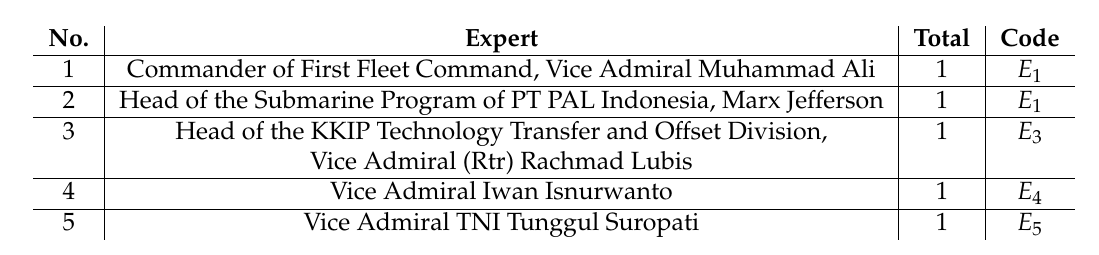
Table 3. SSIM symbol rules